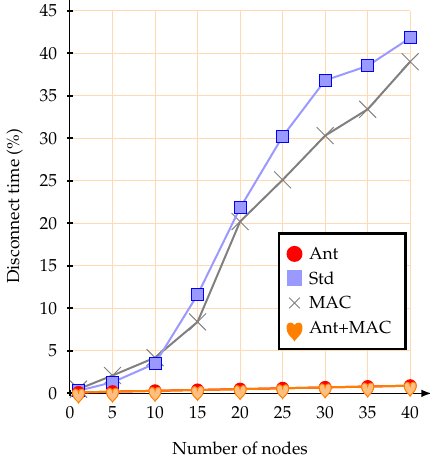
Figure 8. Average percentage of disconnect time at 1.4